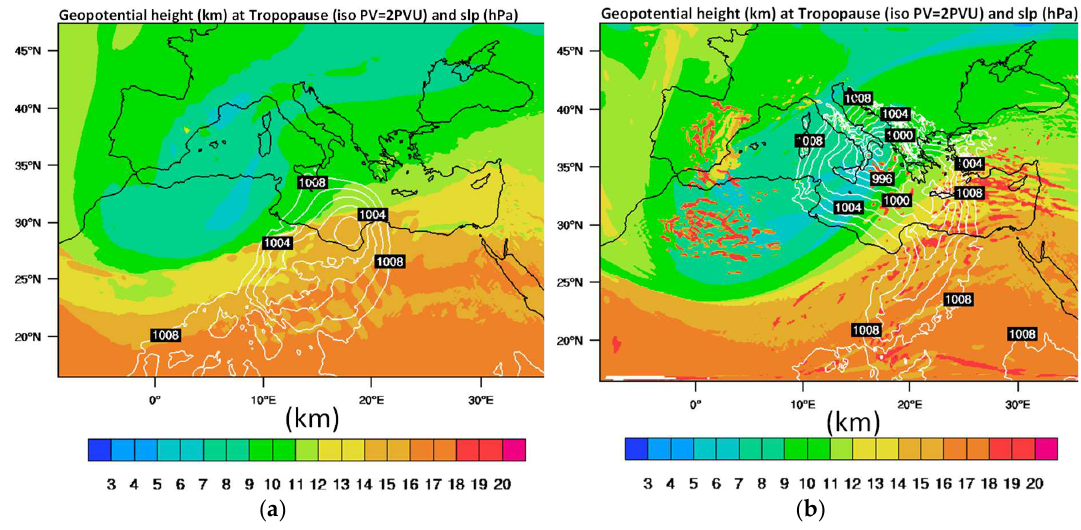
Figure 4. Geopotential height (km) at the dynamical tropopause (iso-PV = 2 PVU) and sea level pressure (white contours every 2 hPa) at: ( a ) 21 March 2018, 1800 UTC and ( b ) 22 March 2018, 1200 UTC.